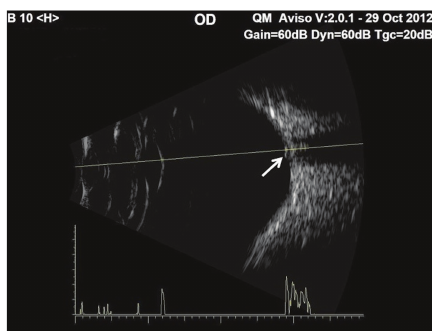
Figure 4: B-scan (low gain) of the right optic disc showing moder- ately high reflectivity consistent with surface ODD